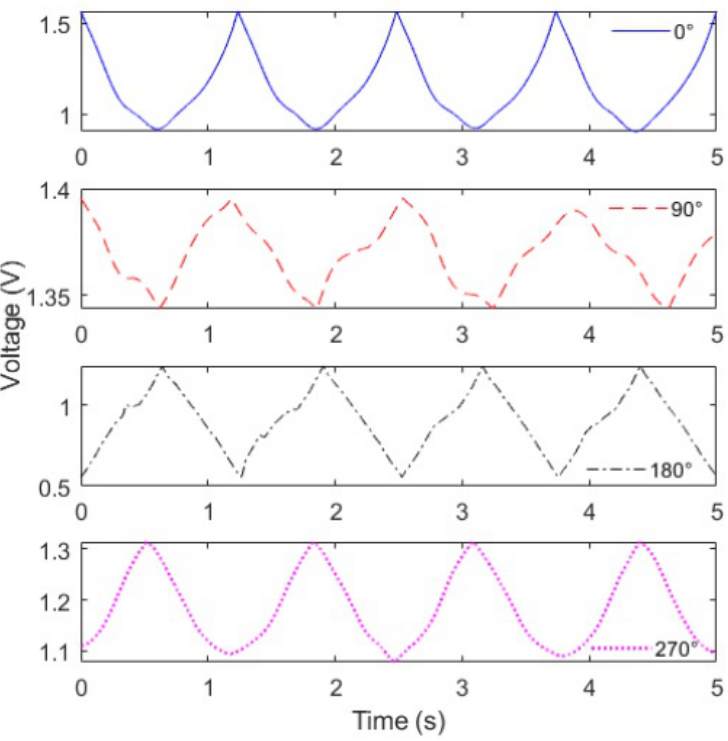
Figure 6. Optical power variation (represented by the voltage variation) of the POF sensor for different positions of the lateral section at flexion and extension cycles (from 0 ◦ to 80 ◦